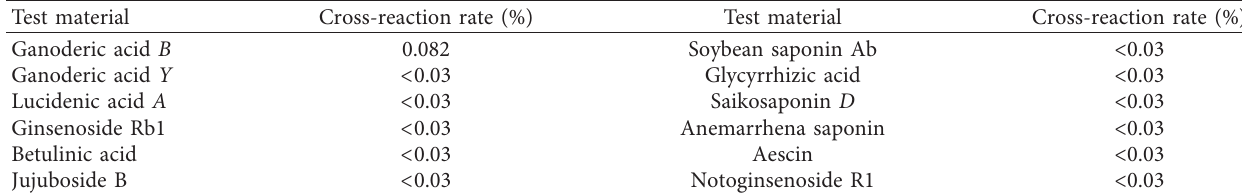
Table 3: Results of the cross-reaction between test substance and ganoderic acid A